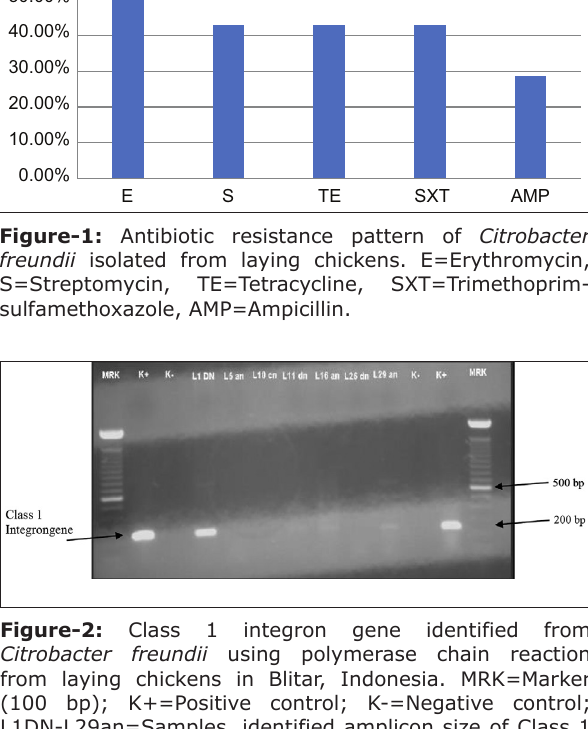
genes encoding Class 1 integrons in poor sanitation